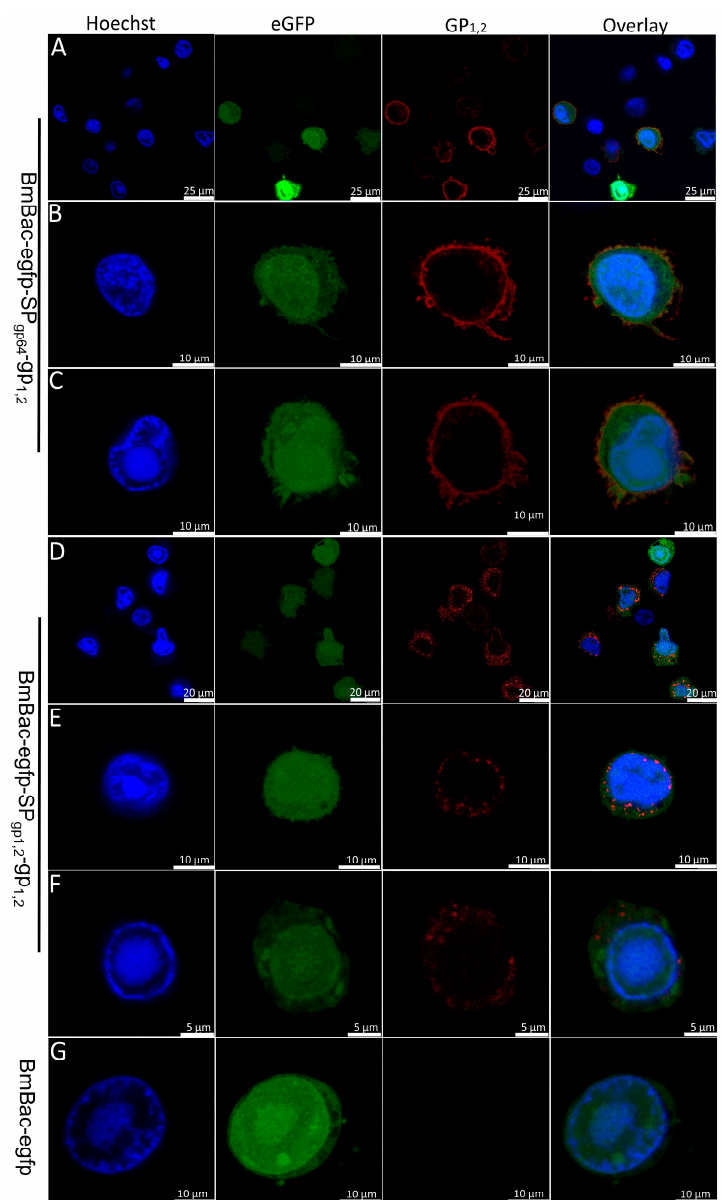
Figure 3. Subcellular localization of EBOV-GP in infected BmN cells. Cells were infected with BmBac-egfp-SP gp1,2 -gp 1,2 ( A – C ), BmBac-egfp-SP gp1,2 -gp 1,2 ( D – F ), and BmBac-egfp ( G ), at an multiplicity of infection (MOI) of 5 and prepared for confocal imaging at 48 h p.i. For immunofluorescence assays,